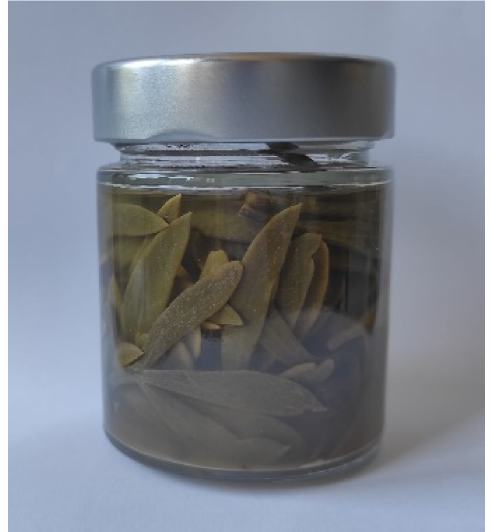
Figure 1. Probiotic-enriched sea fennel sprouts soaked in